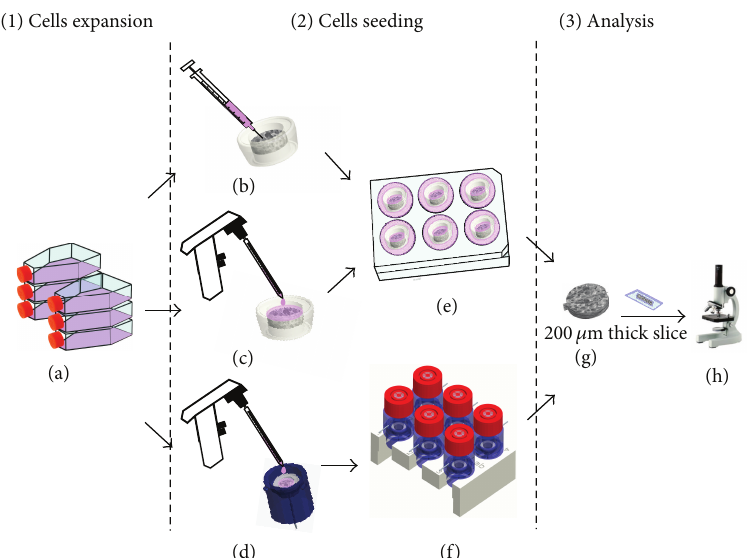
Figure 3: Cell culture experiments performed for the evaluation of the dynamic perfusion seeding. (1) Cell expansion: cell line MC3T3-E1 was cultured in standard T-flask in cell culture incubators (5% CO 2 , 37 ∘ C) and passaged when 60–70% confluence was reached (a). (2) Cell seeding: the seeding density was about 2 × 10 5 cells/50 𝜇 L of culture medium, and the scaffolds were porous PCL matrices with a porosity of 84%. Suspended cells were injected (b) or dropwise seeded (c, d) onto the scaffolds. Injection- (b) and dropwise-seeded (c) scaffolds were fixed within holder cartridges and incubated in a six-well plate for 6 hours. In addition, cell suspensions were poured on the top surface of each scaffold fixed in a holder cartridge within a perfusion culture chamber (d); then the bioreactor was closed (f), and incubated for 6 hours. (3) Analysis: formalin-fixed scaffolds were cut into 200 𝜇 m thick-longitudinal sections (g), and the distribution of the seeded cells within the thickness of the scaffold was observed via fluorescence microscopy after cell nuclei staining